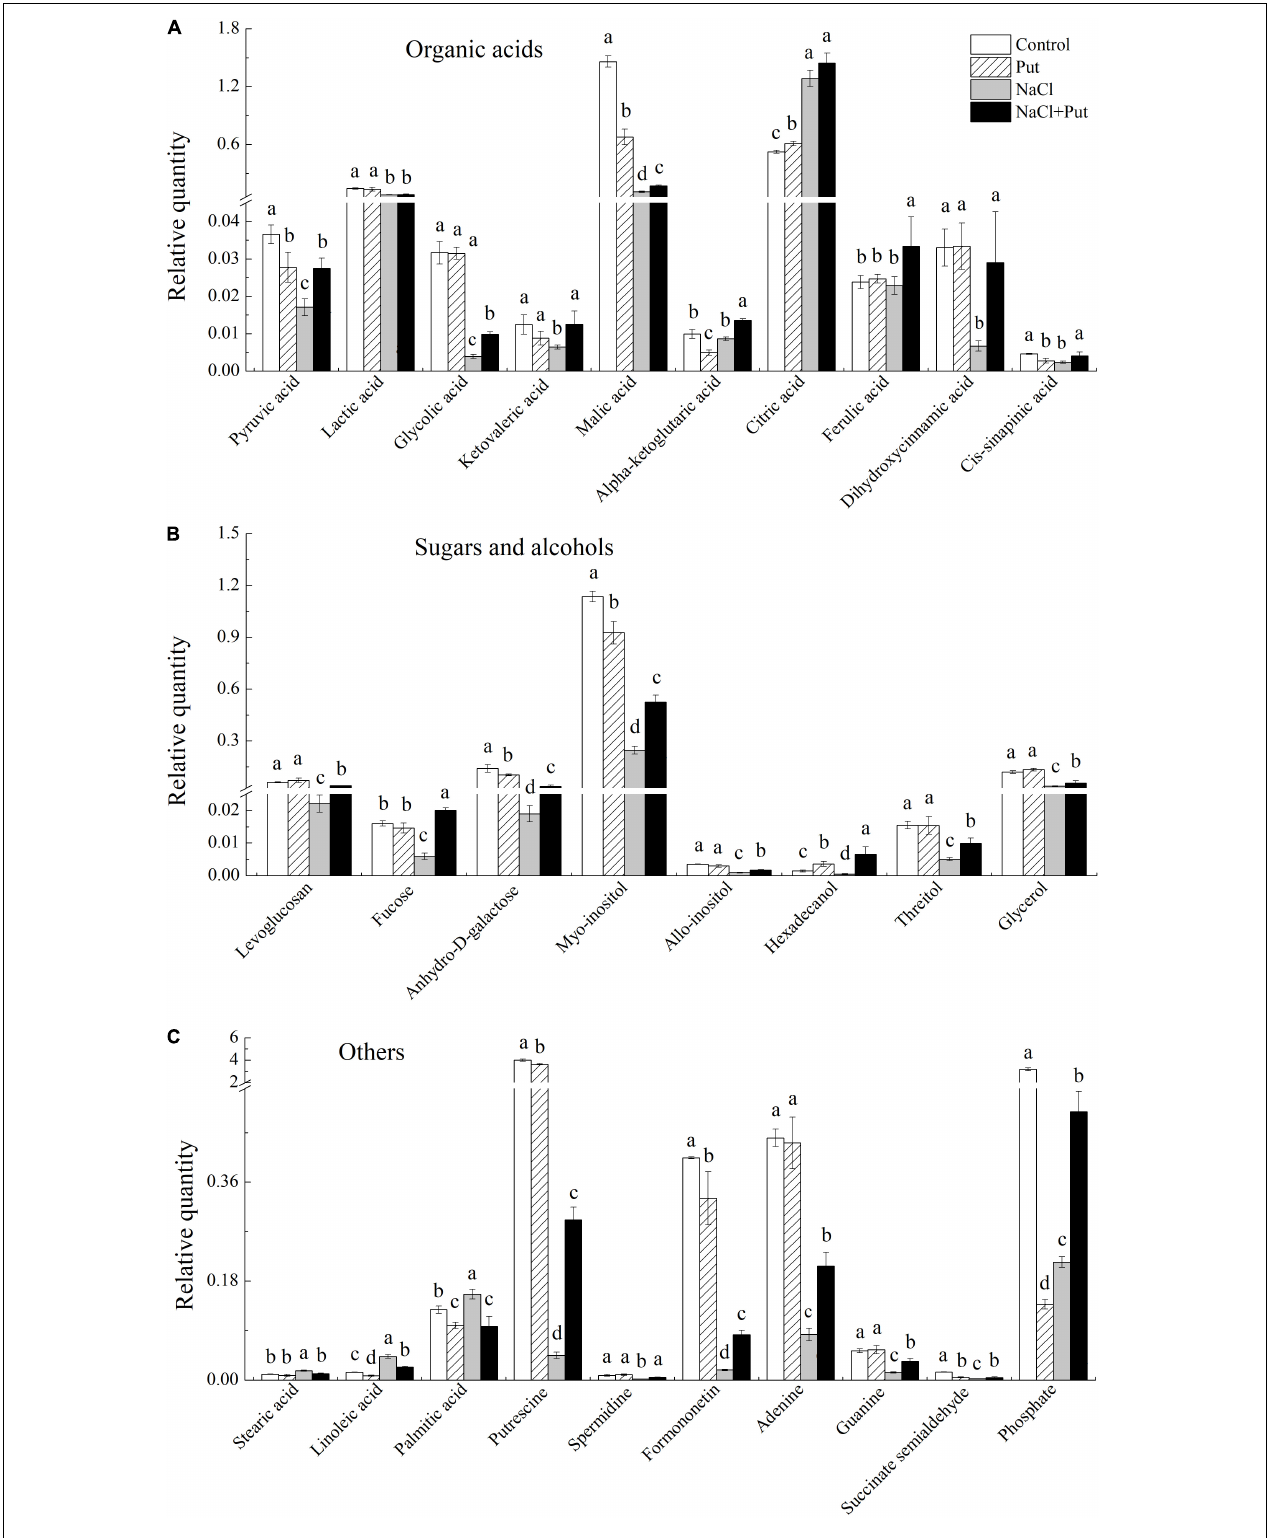
FIGURE 7 | Effects of seed soaking with Put or water on (A) organic acids, (B) sugars and alcohols, and (C) other metabolites content of white clover seedlings after 7 d of germination under normal condition or salt stress. Vertical bars above columns indicate the standard error of each mean ( n = 4). Different letters indicate a significant difference ( P ≤